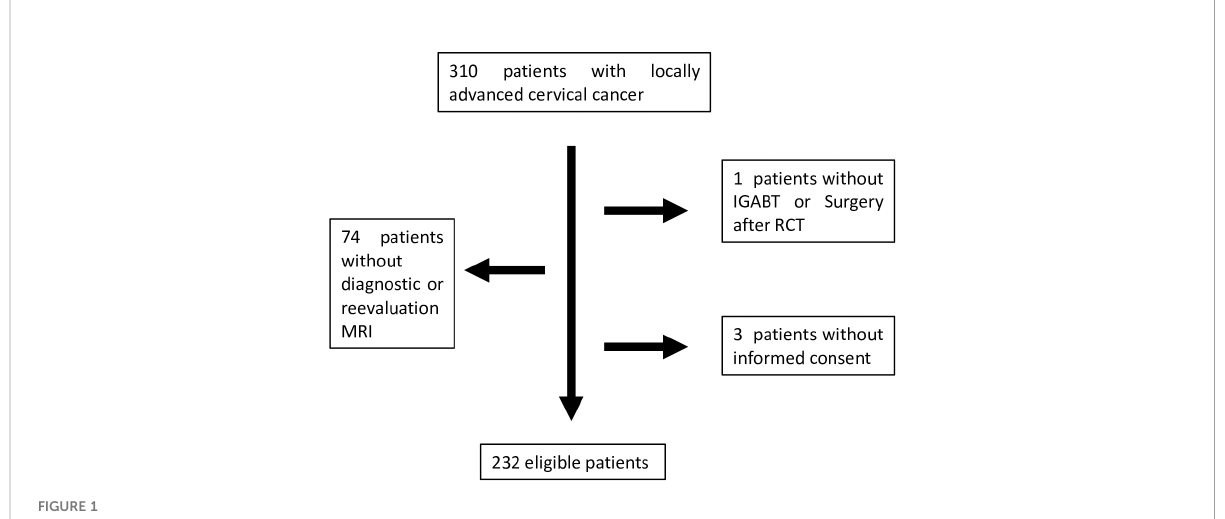
FIGURE 1 Flowchart showing patient selection.